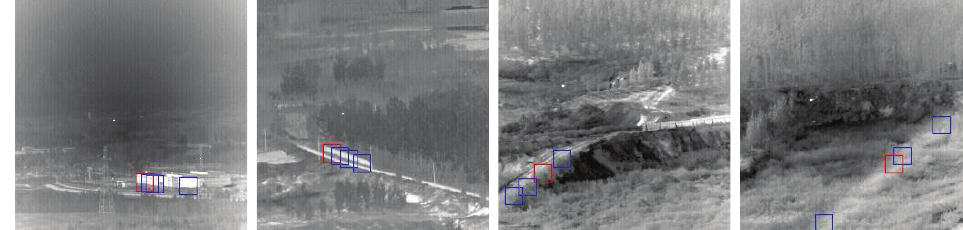
Figure 1. Illustration of matching blocks of infrared images. Each image shows a reference block marked with red borders and a few of the blocks marked with blue borders matched to